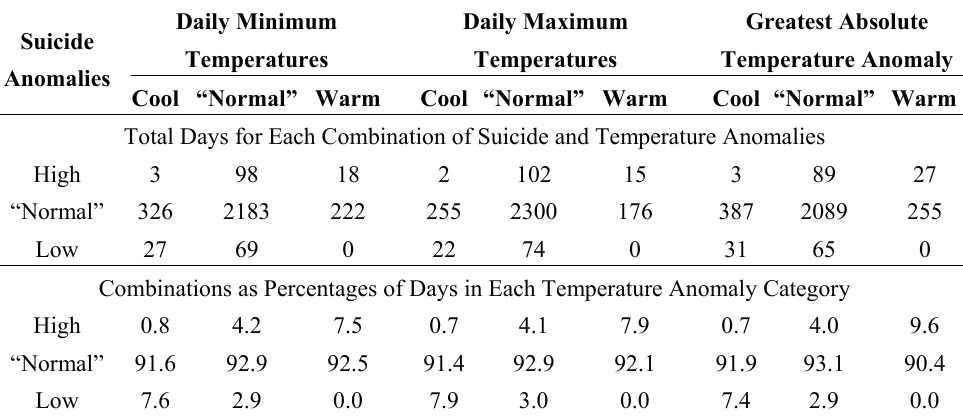
Table 1. Summary of the frequency of days for each combination of suicide and temperature anomalies for